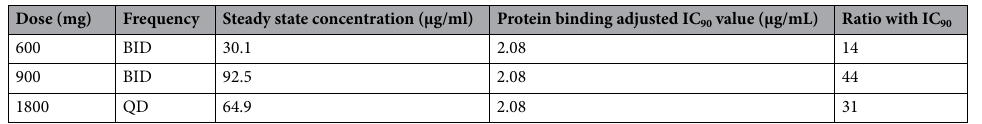
Table 1. Steady state concentration and ratio to protein binding adjusted IC 90 value after different probenecid doses.